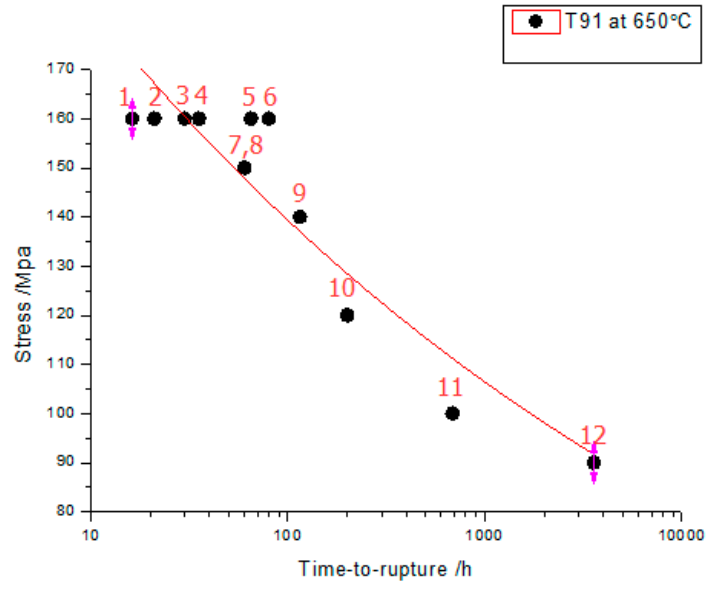
Figure 2. Creep curve of T91 at 650 °C.